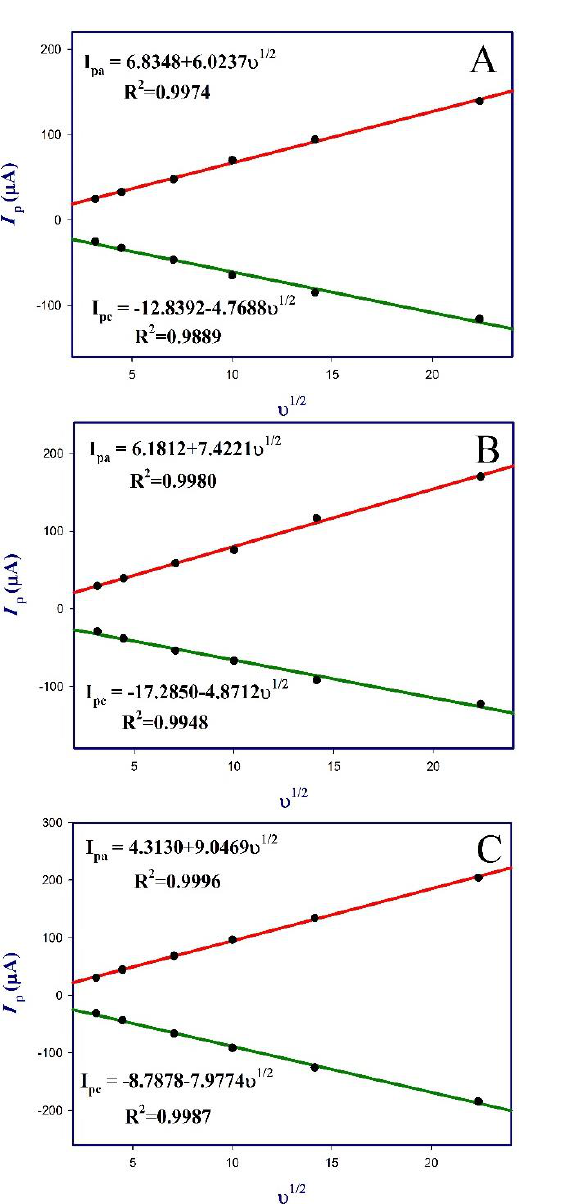
Figure 5. CV at different scan rates from 0.01 V s −1 to 0.5 V s −1 using 1 mM [Fe(CN) 6 ] 3 − /4 − in 0.1 M KCl solution for: ( A ) Bare GCE, ( B ) AuNPs-GCE and ( C ) poly ( DL -met)/AuNPs-GCE. Linear relationship between the anodic and cathodic peak currents of [Fe(CN) 6 ] 3-/4- and square root of the scan rate for: ( D ) Bare GCE, ( E ) AuNPs-GCE and ( F ) poly ( DL -met)/AuNPs-GCE.